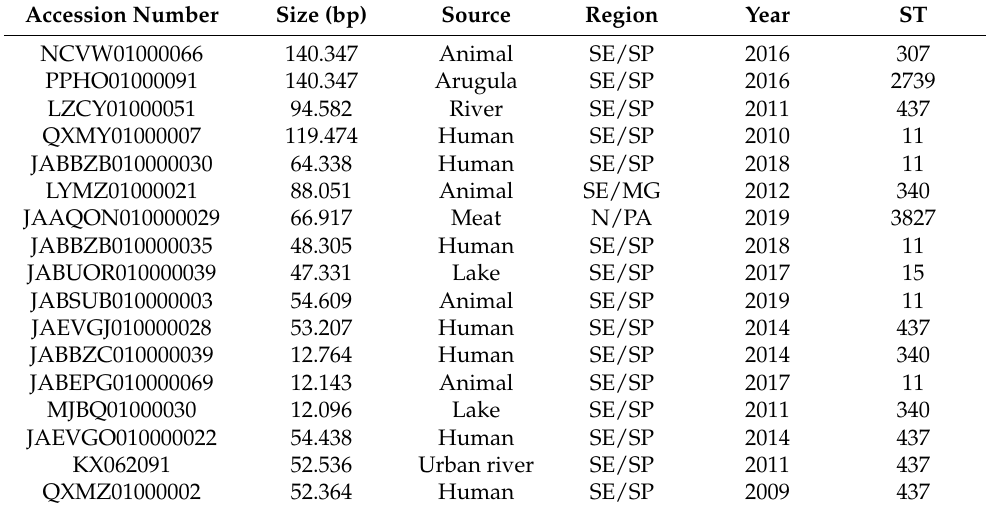
Table 5. Putative plasmids shared between Klebsiella